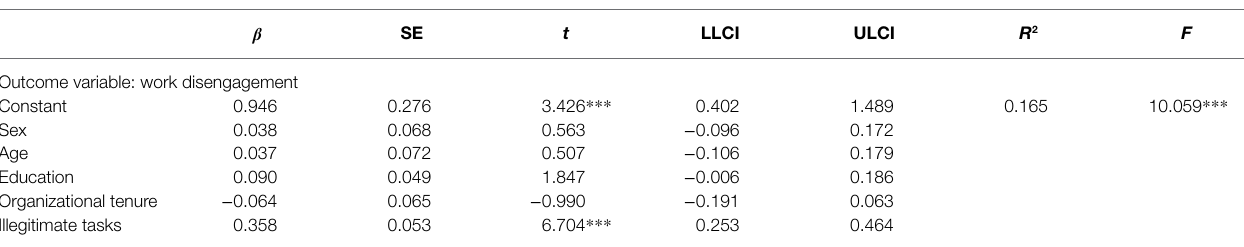
TABLE 3 | Results for main effect